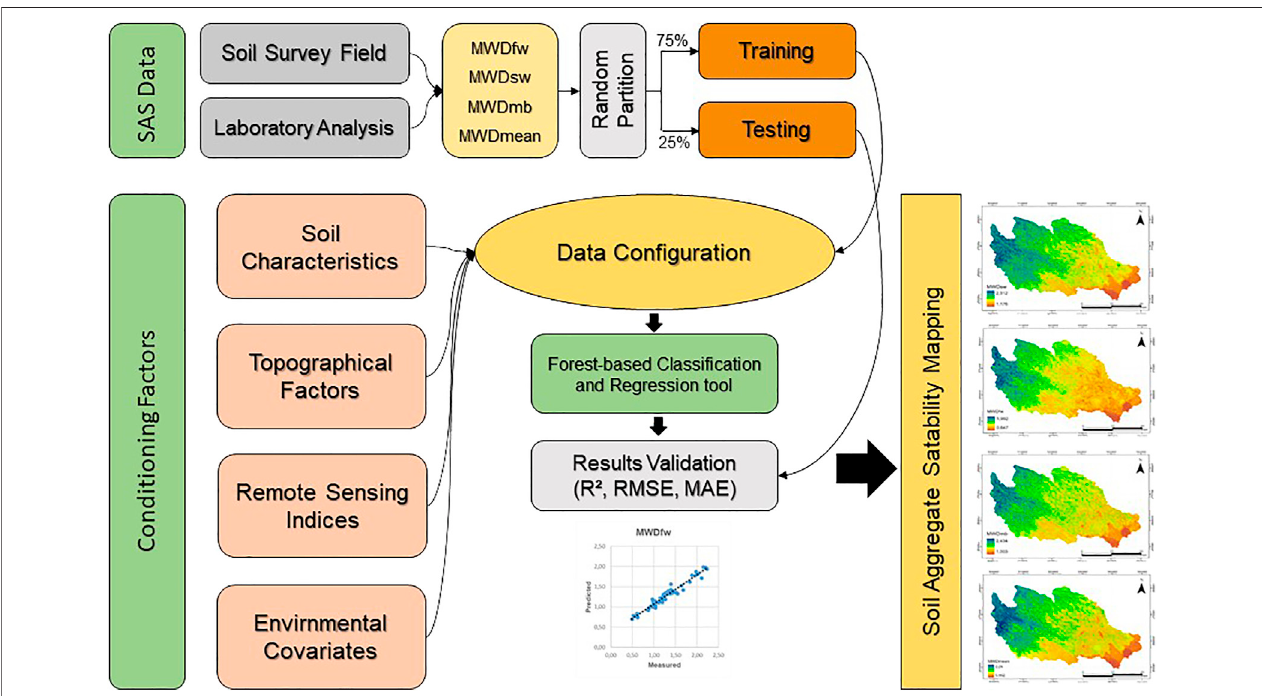
FIGURE 3 | Methodological fl owchart. SAS, soil aggregate stavility; MWDmb, mechanical breakdown; MWDsw, slow wetting; MWDfw, fast wetting and MWDmean, the mean of the three tests.